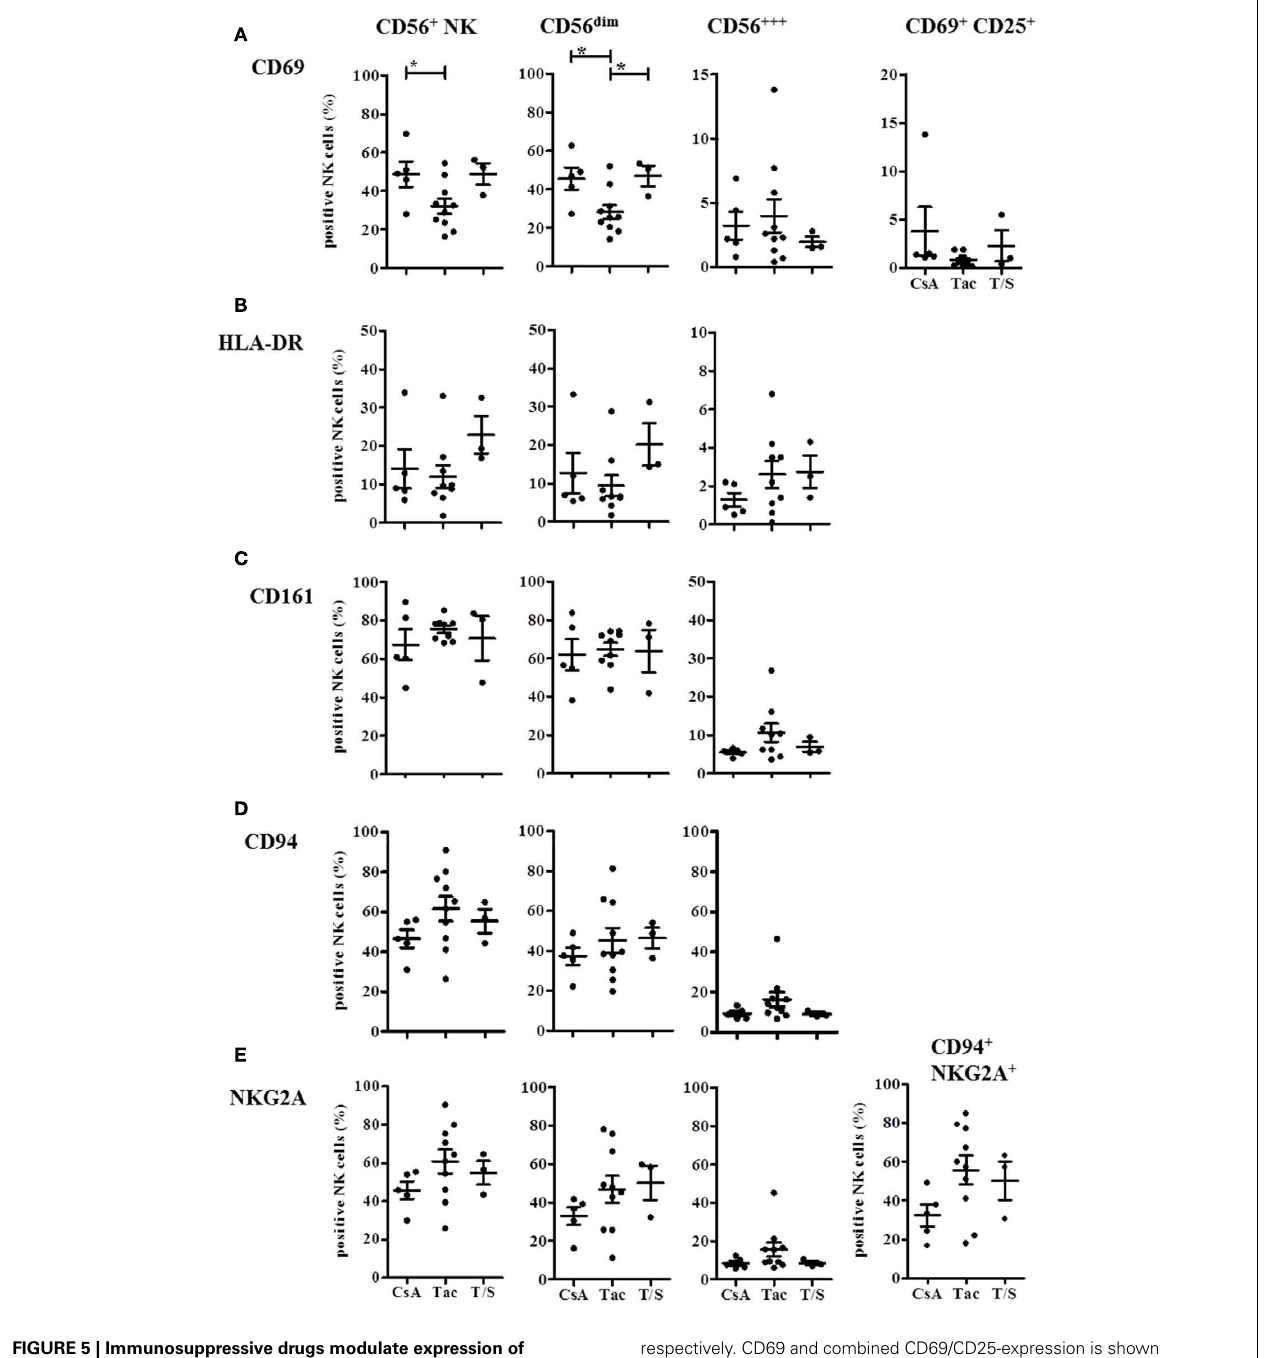
FIGURE 5 | Immunosuppressive drugs modulate expression of CD69, HLA-DR, CD161, and CD94/NKG2A on CD56 bright and CD56 dim NK cells in KTx-patients. KTx-patients ( n = 18) were grouped according to immunosuppressive drugs (CsA,Tac, andT/S) and the expression of several activation markers was analyzed on total CD56 + NK cells and the CD56 bright and CD56 dim subsets,